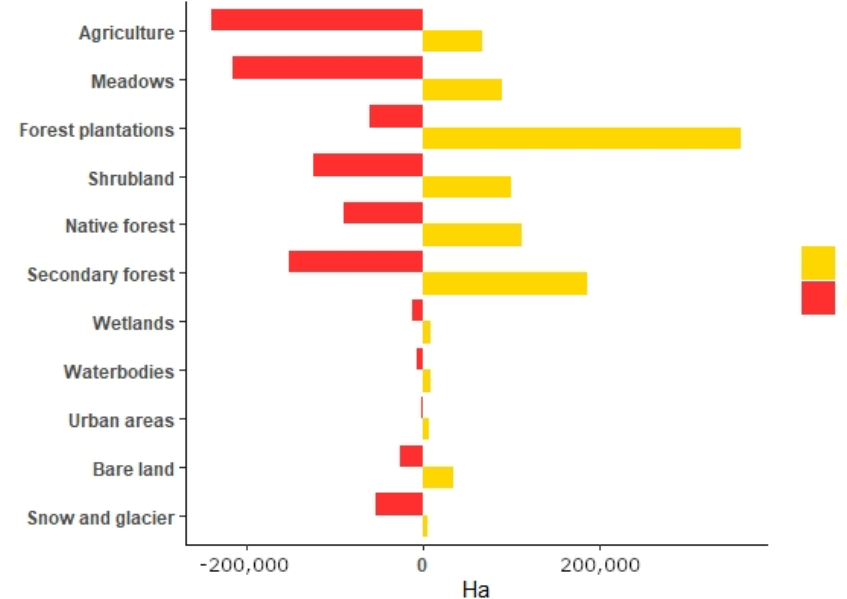
Figure 4. Gains and losses by category of land use/cover change 1997–2013.